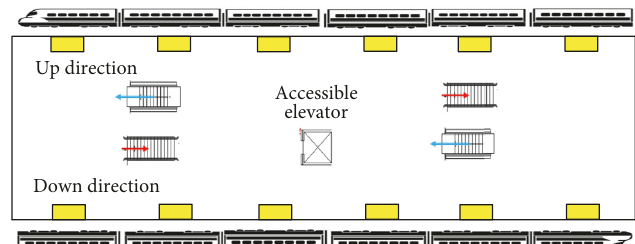
Figure 4: The layout of the platform in QiBao station.